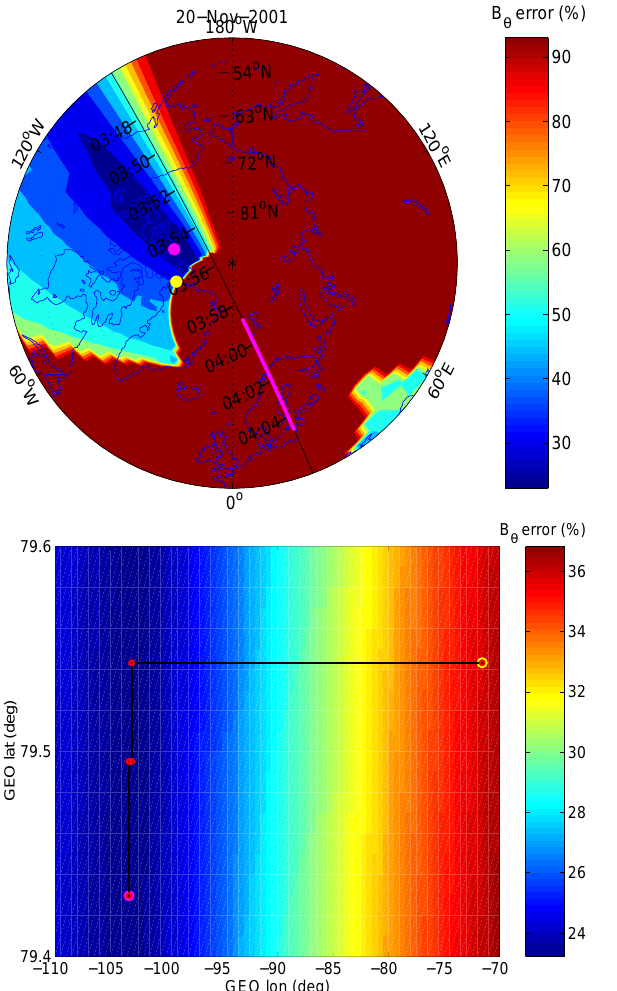
Fig. 6. Top: A typical example of the 1D:ness optimization. The black line with the time stamps shows the track of the CHAMP satellite. The 1D optimized part ( overflight ) is highlighted in magenta. The color coding according to the color bar on the right hand side of the plot displays the B θ error (Eq. 1) for the overflight with the 1D SECS pole at each location. The yellow dot shows the starting-point for the optimization at the geomagnetic pole and the magenta dot the resulting 1D SECS pole at 79 ◦ latitude and − 103 ◦ longitude with B θ error of 23%. Bottom: A zoom in of the top panel showing also the steps taken during the optimization as red dots connected by a black line. Fig. 8. Top: − J φ /J θ and α measured by EISCAT as a function of geographic latitude. The vertical, blue, slashed line denotes the location of the radar. The relative error between the 1D SECS and EISCAT α at that location is written in blue. The current densities and magnetic fields are displayed in Fig. 7. Bottom: The black curve denotes the track of the satellite, with the part displayed in the upper panel higlighted in magenta. The black dot in the cyan square denotes the location of the radar, and the blue line denotes the closest distance between the radar and the satellite.